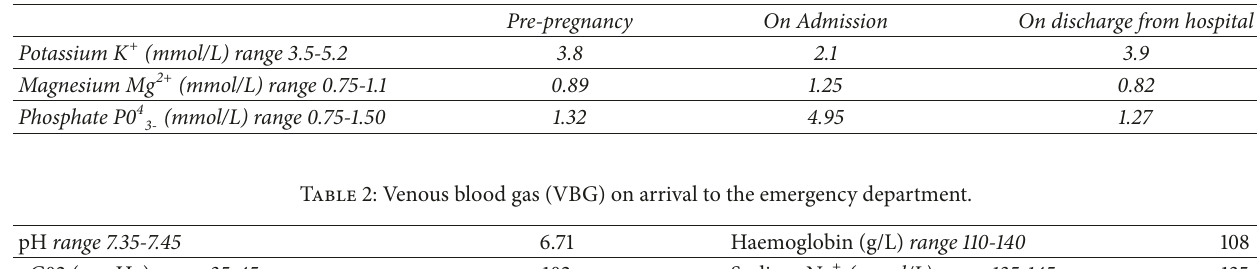
Table 1: Serum electrolytes.